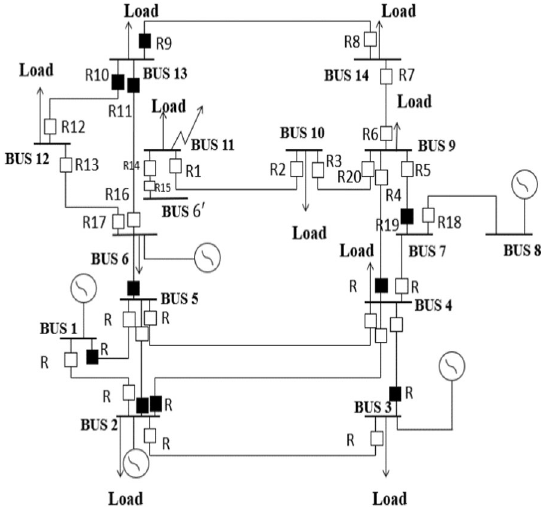
Fig. 6 IEEE 14-bus system with busbar splitting